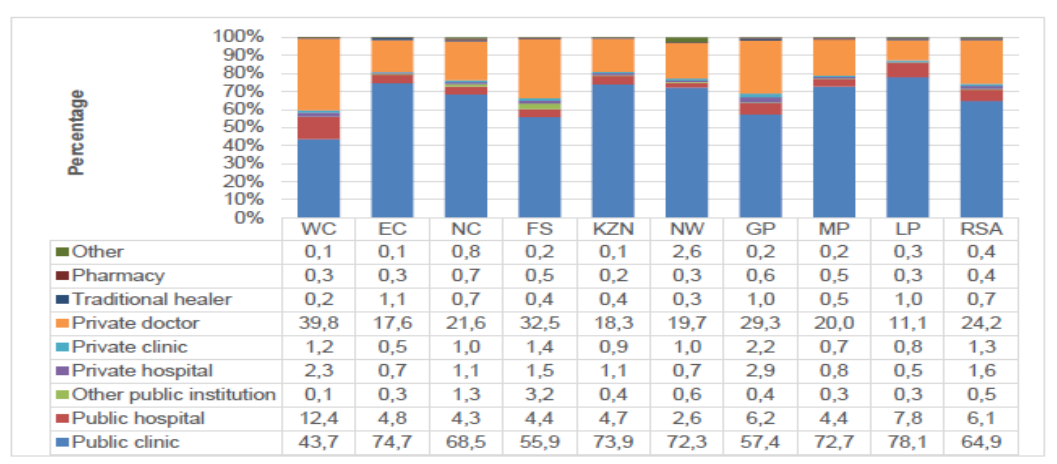
Figure 1: Type of healthcare facility consulted first by the households when members fall ill or are injured in South Africa ; Source: STATSSA